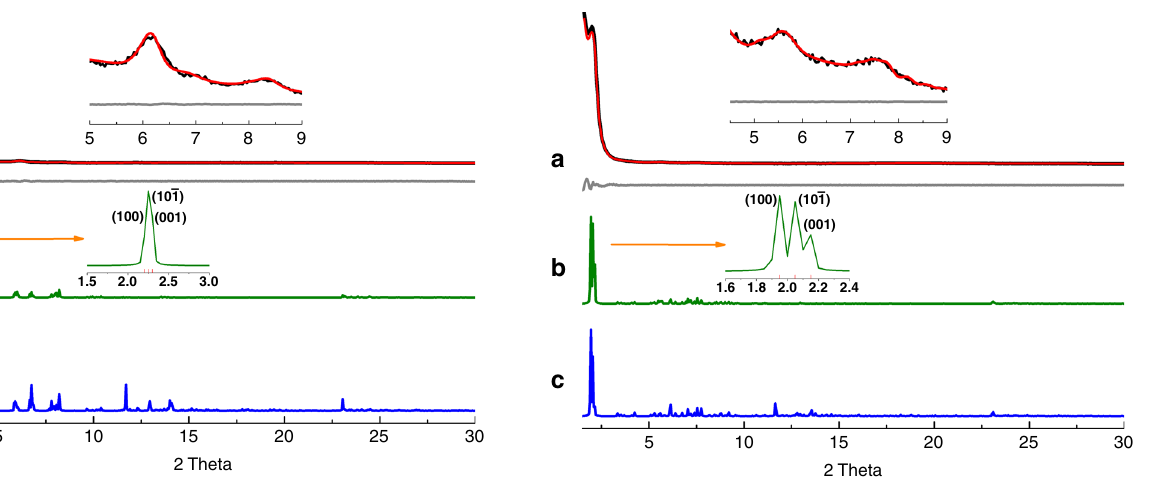
Fig. 5 PXRD pro fi les of Tetra-COF-BZ . a Experimental (black) and Pawley re fi ned (red) PXRD patterns and difference plot (gray) between them, b simulated PXRD patterns with AA stacking, and c AB stacking